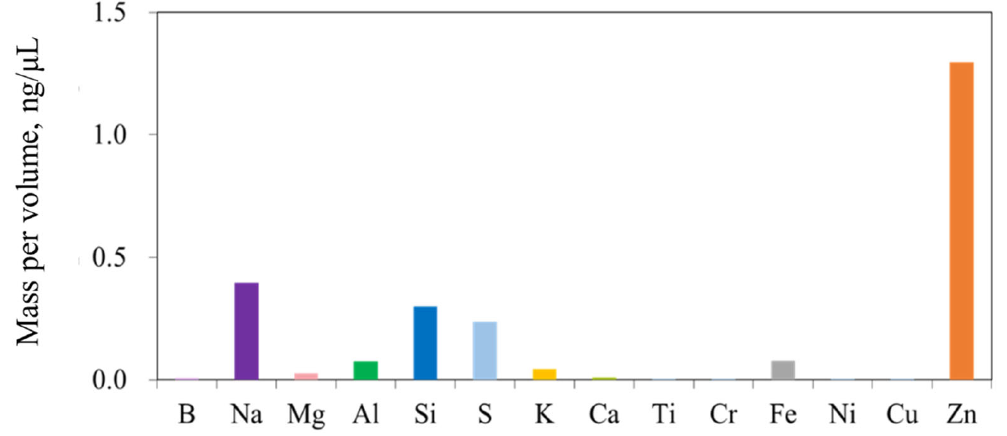
Figure 8. The distribution of metal components in the tire samples.